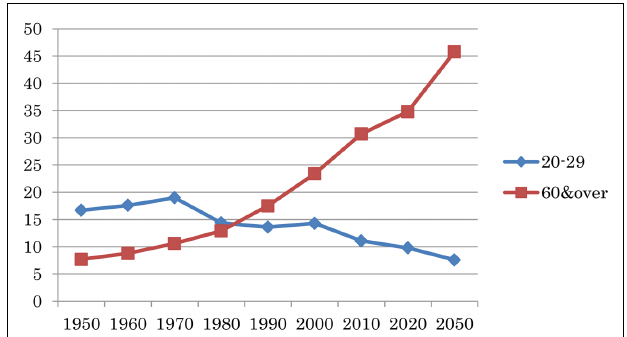
FIGURE 1 |The share of 20- to 29-year-olds and those aged 60 and above relative to Japan’s total population (1950–2010, with projections for 2020 and 2050). Sources: Statistics Bureau (http://www.stat.go.jp/data/ jinsui/2.htm) and Japan Aging Research Center (http://www.jarc.net/aging/ jp/06feb/060203JARC_Population.pdf). Accessed on January 20,